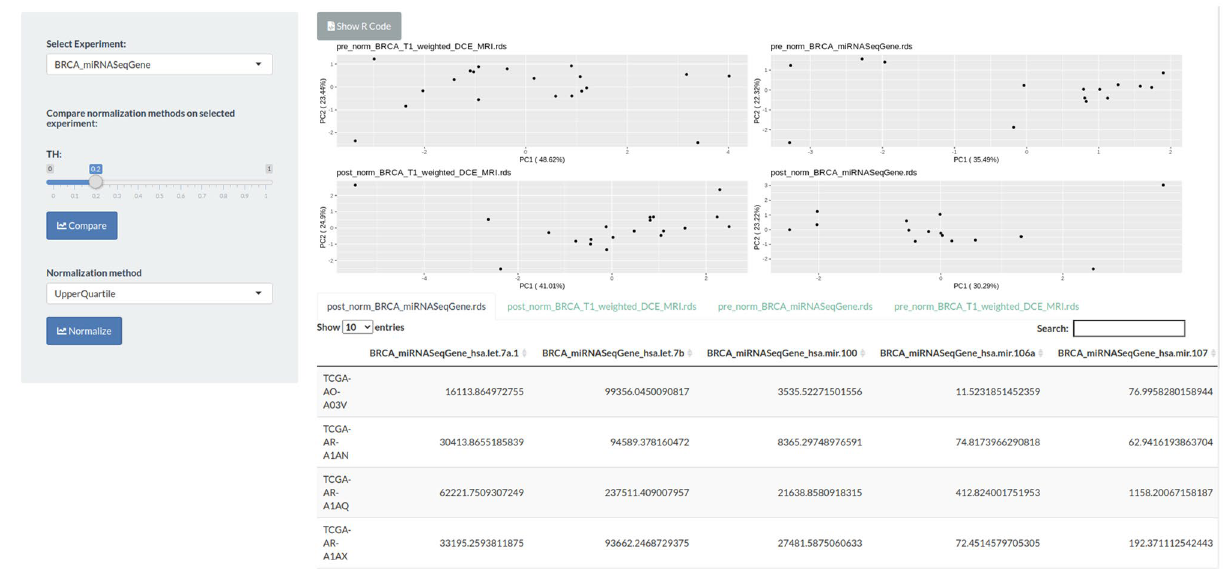
Figure 5. Normalization module. In the Normalization module, the user can choose the normalization method to apply on each single experiment. A PCA plot is displayed for each pre- and post-normalization experiment. Moreover, the table with all processed data is displayed at bottom of the main page. This step is optional. In this example, radiomic and genomic data are normalized via upper-quartile normalization method per tumor stage II. The figure is generated by using R software version 3.6.1 (https ://www.r-proje ct.org).